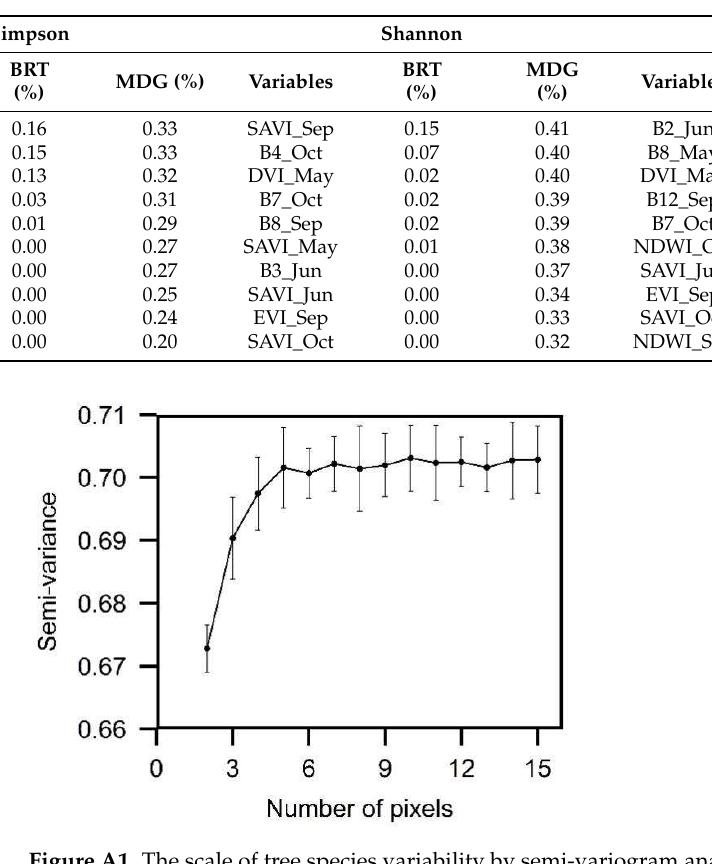
Figure A1. The scale of tree species variability by semi-variogram analysis.